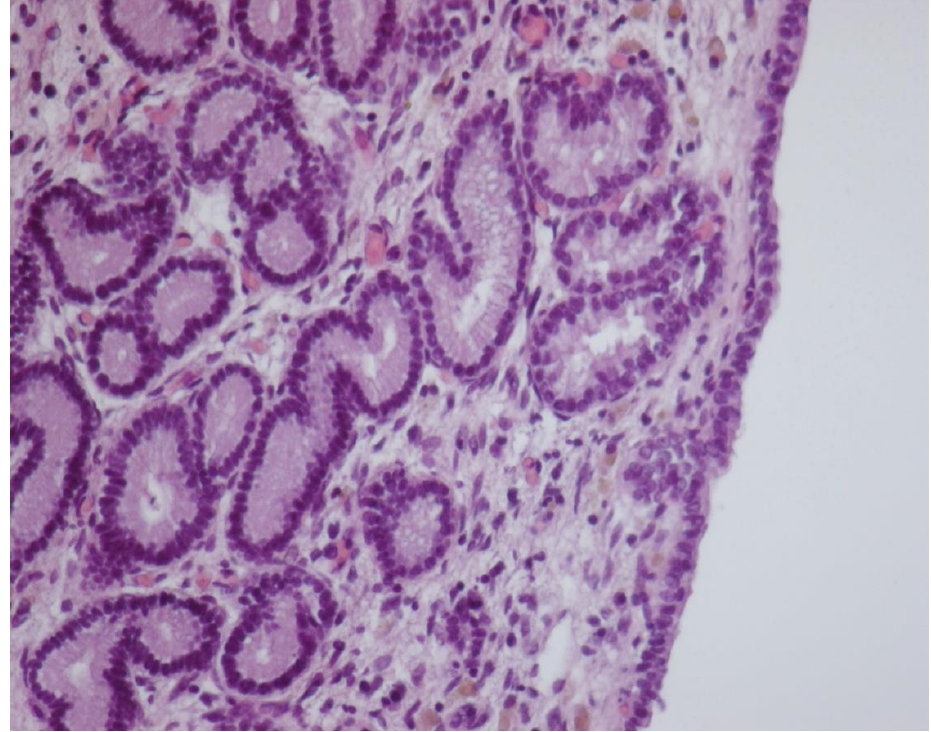
Figure 6. Histologic sampling at postpartum day 14. Cubic continuing epithelium with numerous